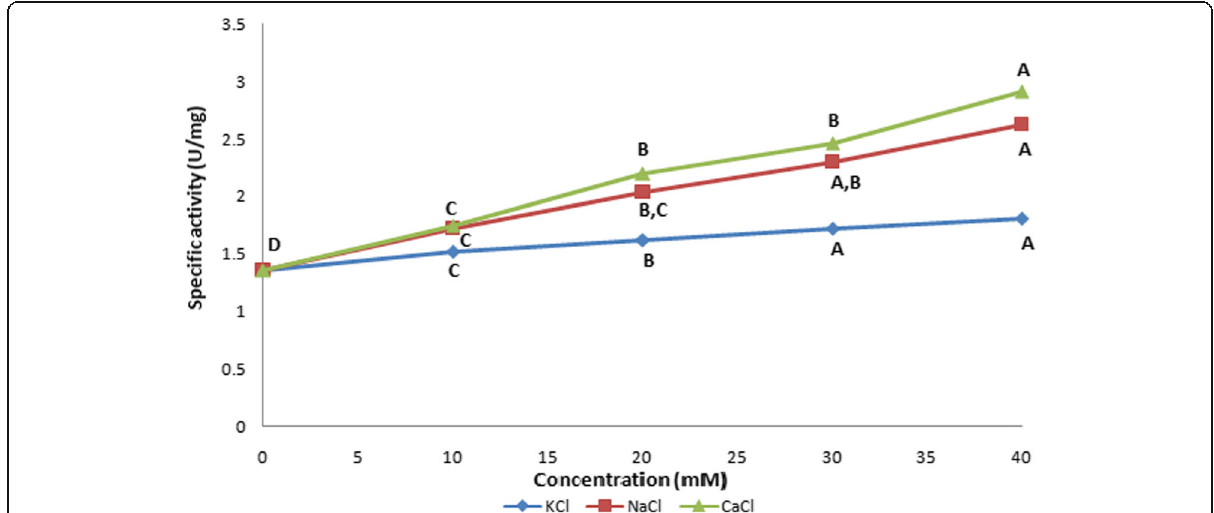
Fig. 7 Effect of KCl, NaCl and CaCl 2 on purified lipase from larval fat body tissue of G. mellonella . All experiments were carried out at 37 °C. PNPB (50 mM) was used as substrate. The enzyme reaction was incubated with ions separately for 1 h. Different letters indicate significant differences ( p < 0.05), (no. of replicates = 3)